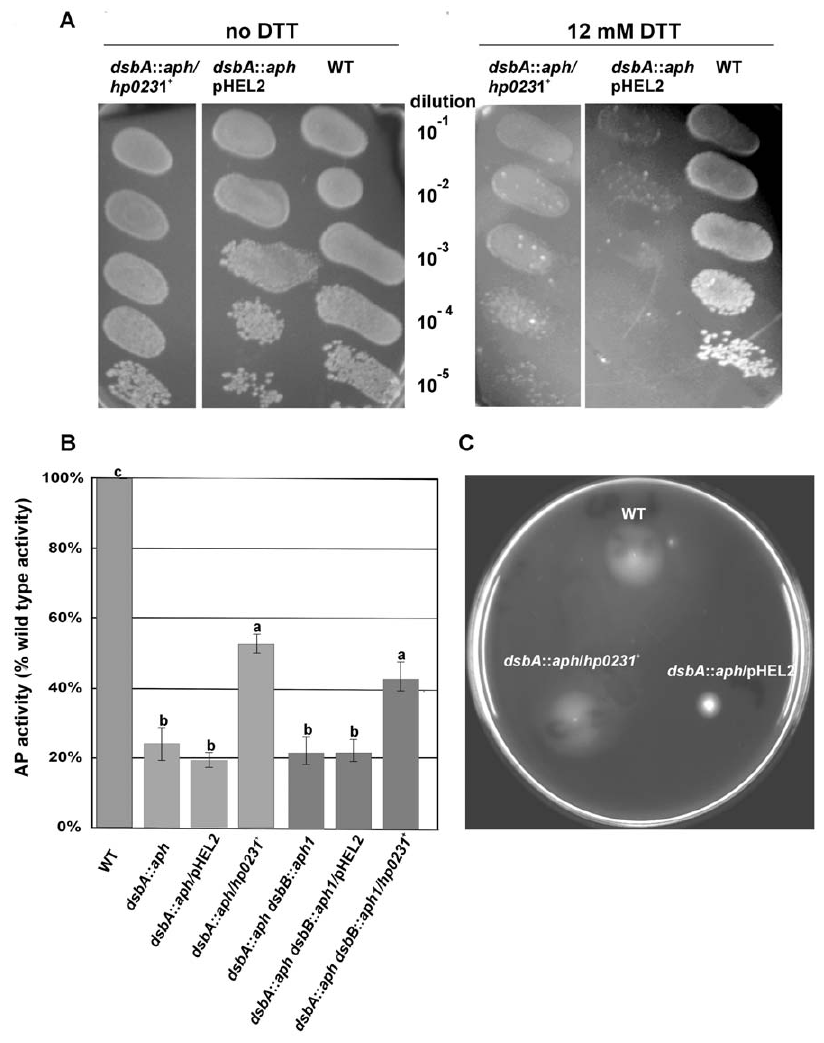
Figure 5. HP0231 restores the E.colidsbA 2 wild type phenotype in three independent functional assays. As a negative control E. coli dsbA :: aph was transformed with an empty pHEL2 vector. Panel A DTT sensitivity assay; panel B alkaline phosphatase assay. The bars represent average activity of three independent experiments with wild type set to 100% activity; error bars with the different letters indicate a significant difference (p , 0.01) in relative alkaline phosphatase activity between the H. pylori N6 wt cells and the mutant strains, and the complementant strains (in ANOVA followed by post hoc Tukey’s test). Alkaline phosphatase activity of wild type and dsb mutants and complementants strains was performed in M63 minimal media; Panel C motility